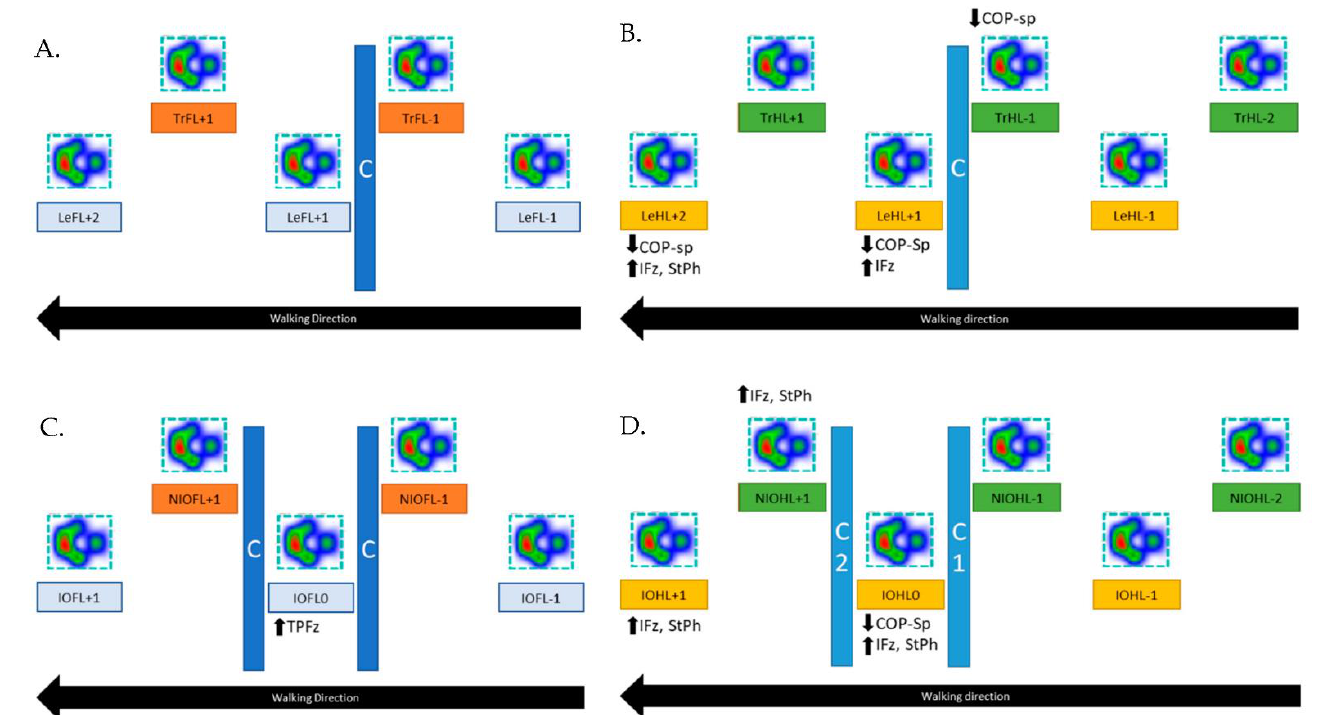
Figure 3. Significant differences between walking over one or two obstacles compared with normal walking are shown. ( A ) Results of the forelimbs during walking over one obstacle. ( B ) Results of the hindlimbs during walking over one obstacle. ( C ) Results of the forelimbs during walking over two obstacles. ( D ) Results of the hindlimbs during walking over two obstacles. COP-sp, COP speed; IFz, vertical impulse; StPh, stance phase; TPFz, time to peak vertical force. All mean values, standard deviation and p -values are given in Appendix A.